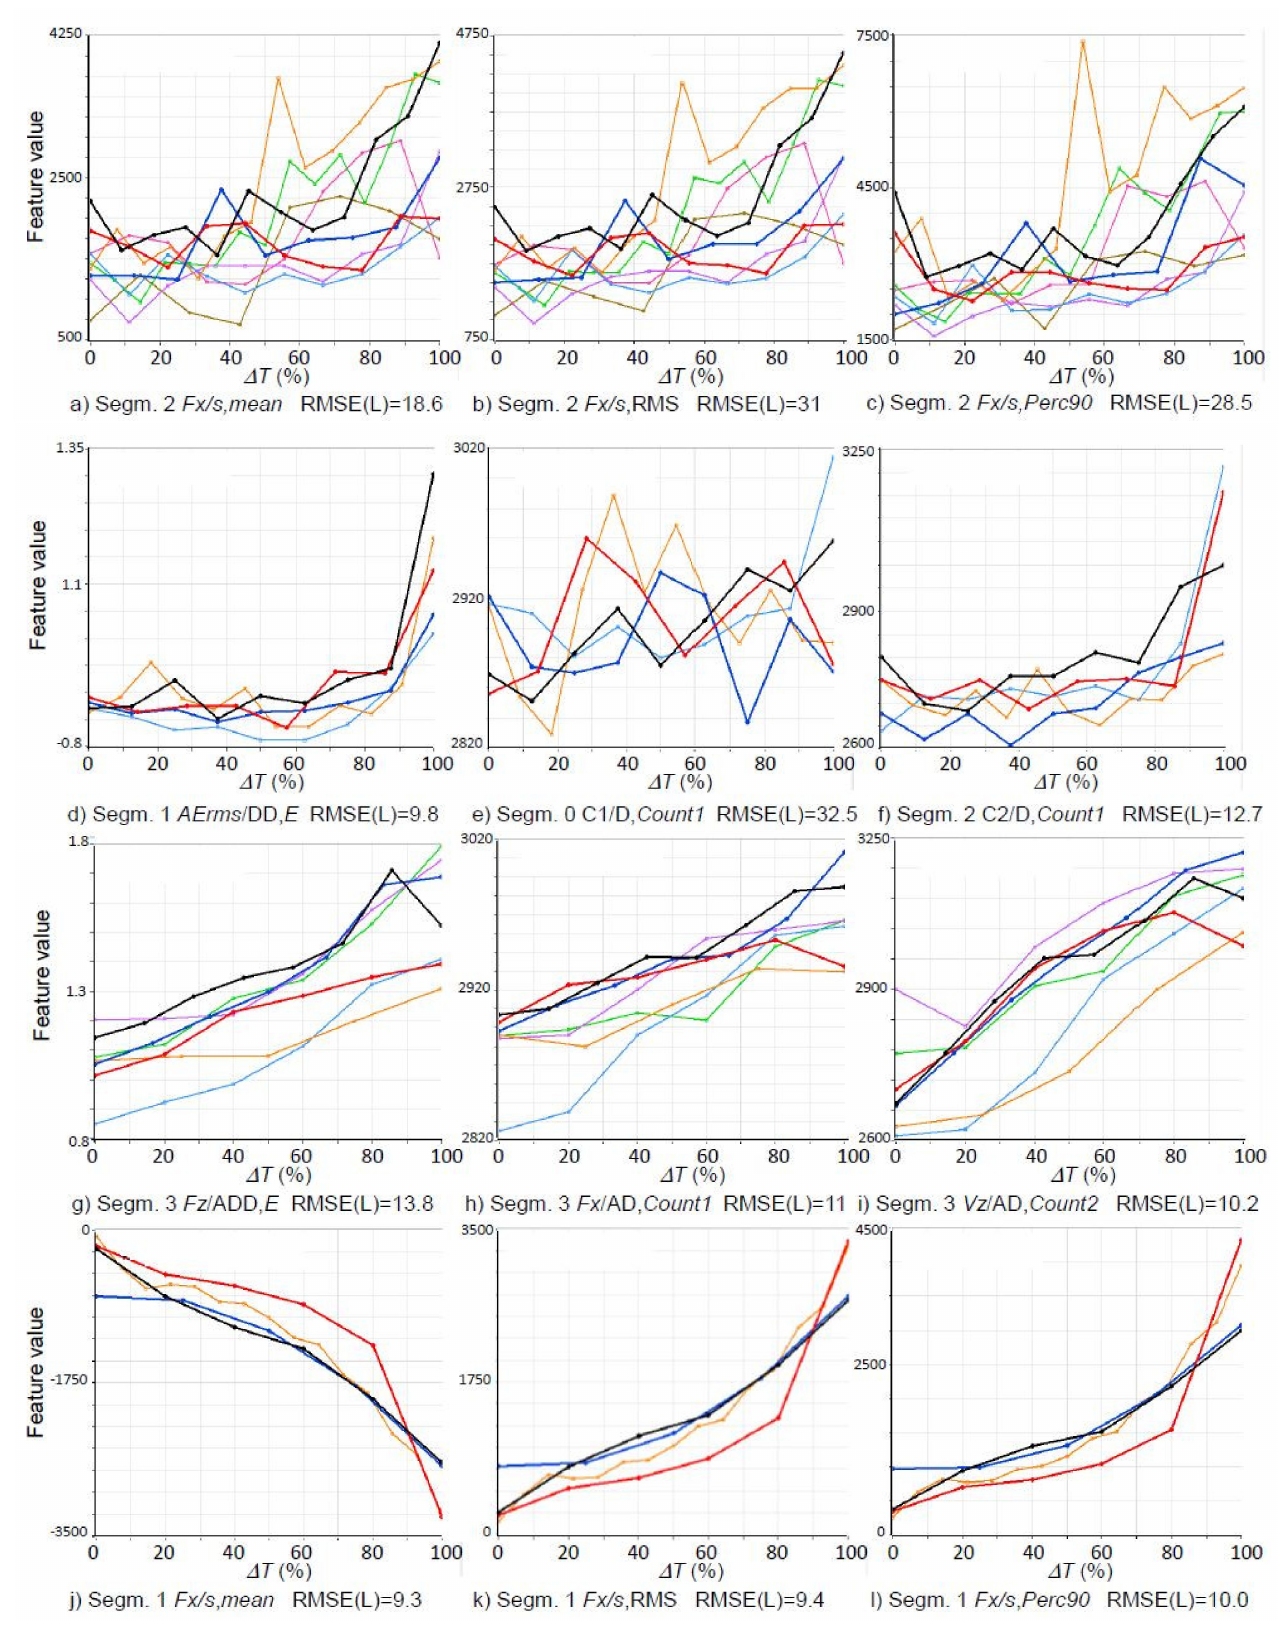
Figure 7. Exemplary courses of SFs obtained for experiment 1 ( a – c ), experiment 2 ( d – f ), experiment 3 ( g – i ) and experiment 4 ( j – l